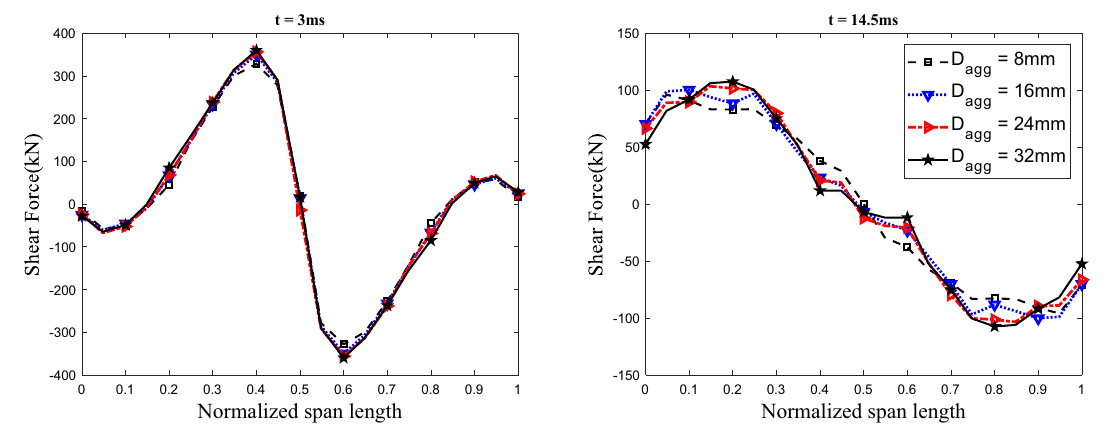
Fig. 19 Shear force diagrams for BM1 at t = 3 ms and 14.5